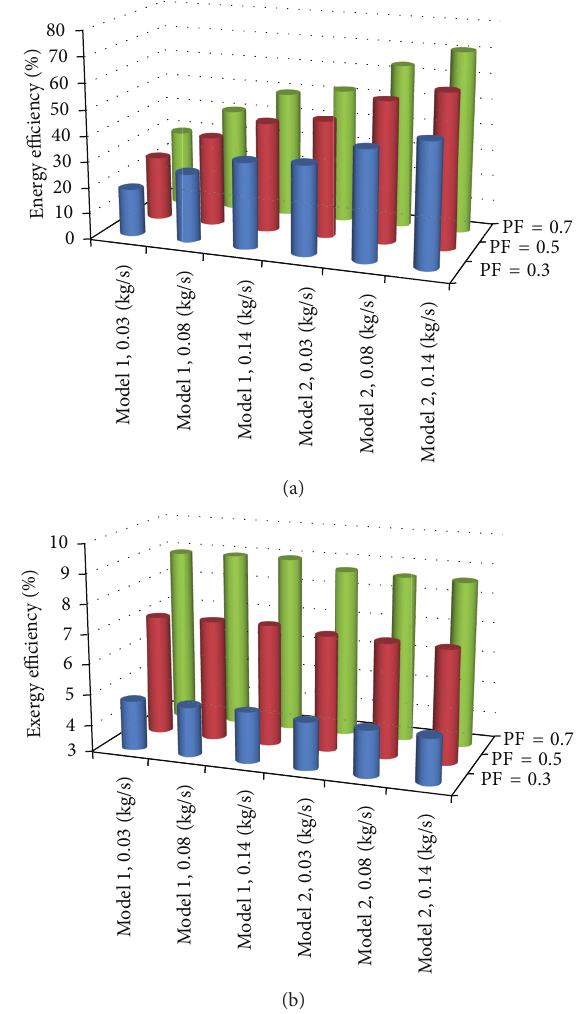
Figure 8: Daily average efficiencies of Models 1 and 2; (a) energy and (b)